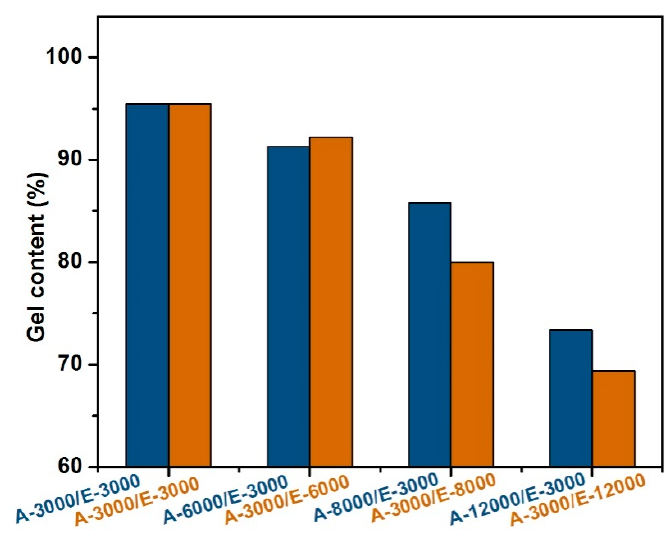
Figure 4. The effect of molecular weight of the two selected polymers on gel content.